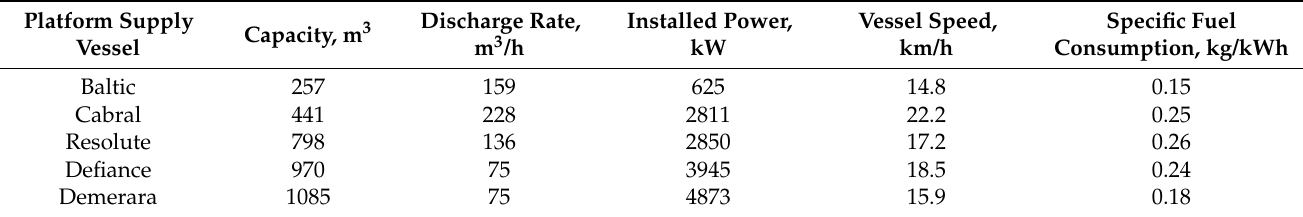
Table 4. Platform supply vessel